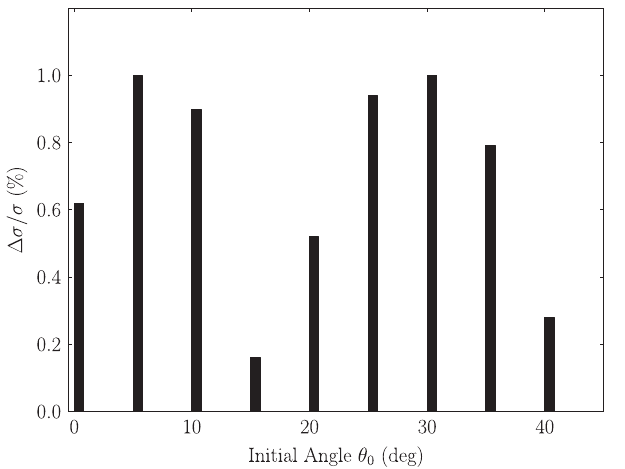
FIG. 10. Mean value of the difference between the curve obtained by fitting 200 projections and the one fitting only 4 projections as a percentage of the